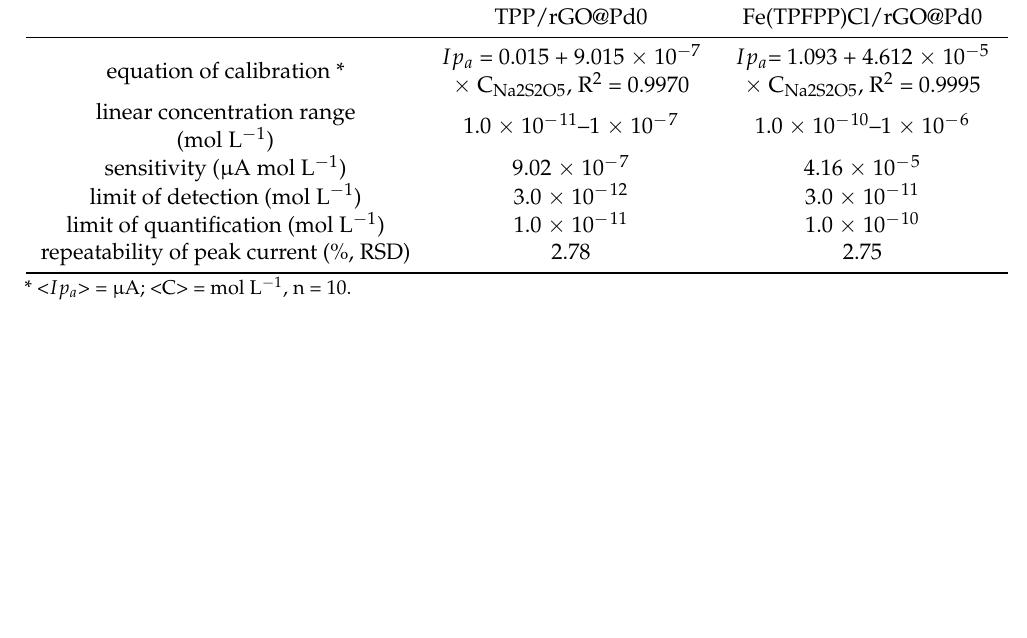
Figure 5. ( a ) Square wave voltammograms of 1.0 × 10 − 4 mol L − 1 Na 2 S 2 O 5 using the Fe(TPFPP)Cl/rGO@Pd0 sensor in PBS at pH values 2.0 − 8.0. ( b ) The effect of the pH on the peak current (black dots) and the linear dependence of the peak potential with the pH (blue line).